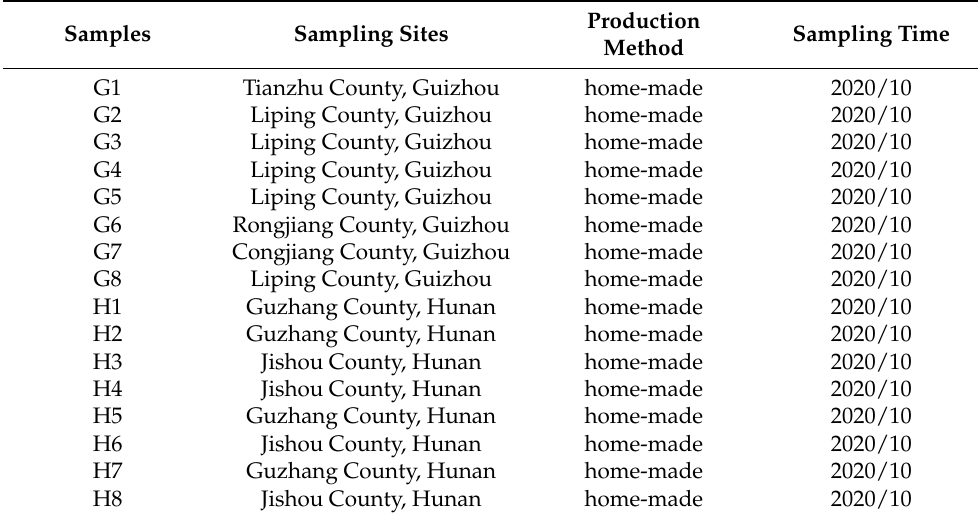
Table 1. Suanyu samples’ collection